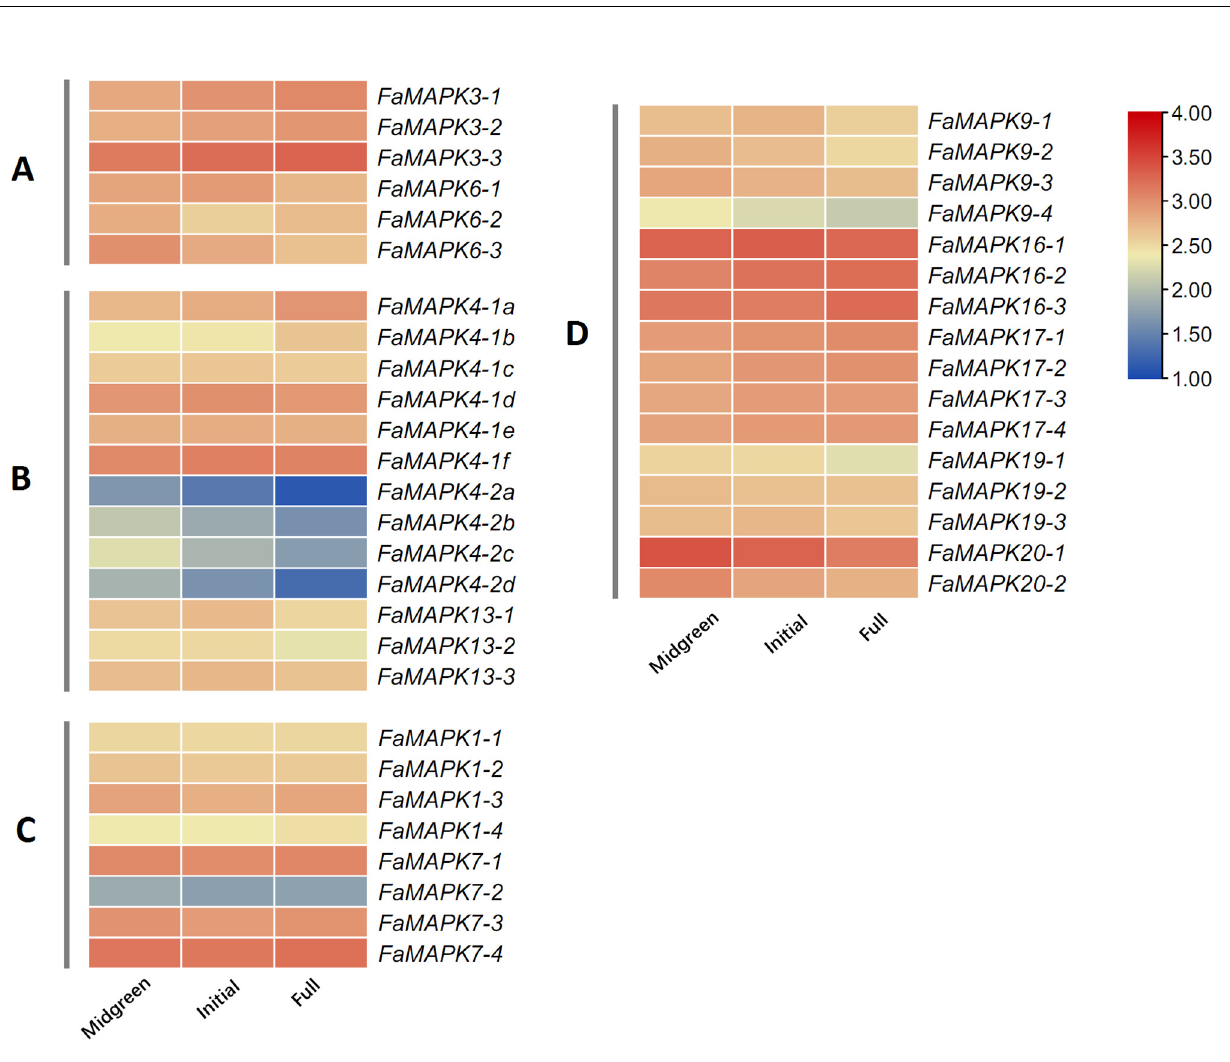
Figure 7. Transcript abundance of FaMAPK genes at different fruit developmental stages. FPKM values of FaMAPK genes were transformed by log2(FPKM + 1), and the heatmap was constructed with TBtools software. Midgreen: medium green stage; Initial: initial red stage; Full: full-red stage.